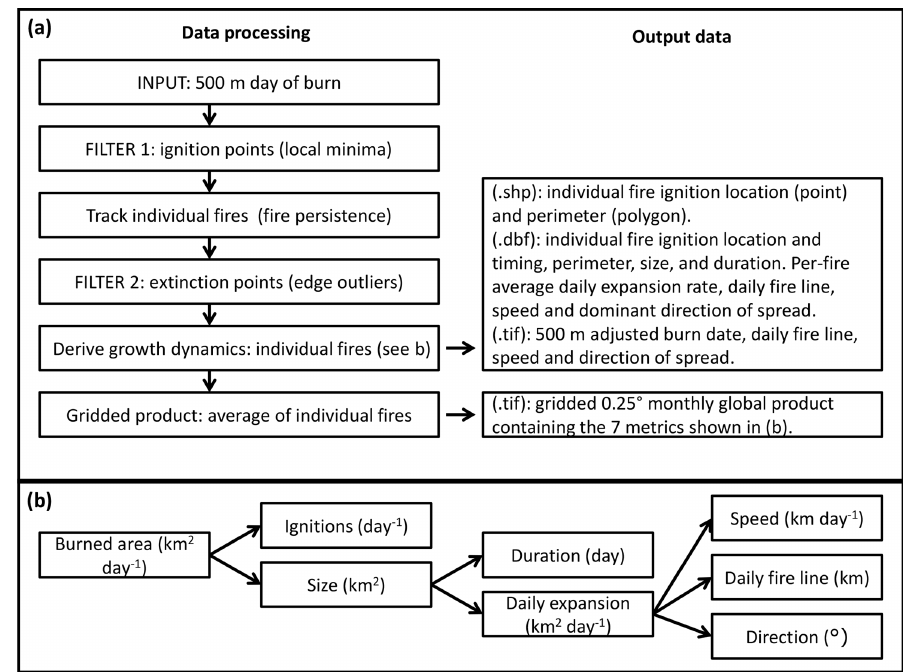
Figure 1. Flowchart showing the data-processing steps and resulting products. (a) The Global Fire Atlas algorithm tracks individual fires and their day-to-day behavior based on the MCD64A1 Col. 6 500m daily burned-area product starting in 2003. (b) Decomposition of burned area into seven different components of the fire regime in the Global Fire Atlas. The output includes two annual shapefile layers (.shp) of the ignition location and individual fire perimeters, with corresponding database files (.dbf) providing summary information for each individual fire, including the seven key characteristics. In addition, four per-fire-year global raster maps on the 500m sinusoidal MODIS grid (.tif) provide details on the day-to-day fire behavior. Finally, data are summarized in a monthly 0.25 ◦ gridded product based on average values of individual fires. Global Fire Atlas data layers are described in more detail in Table